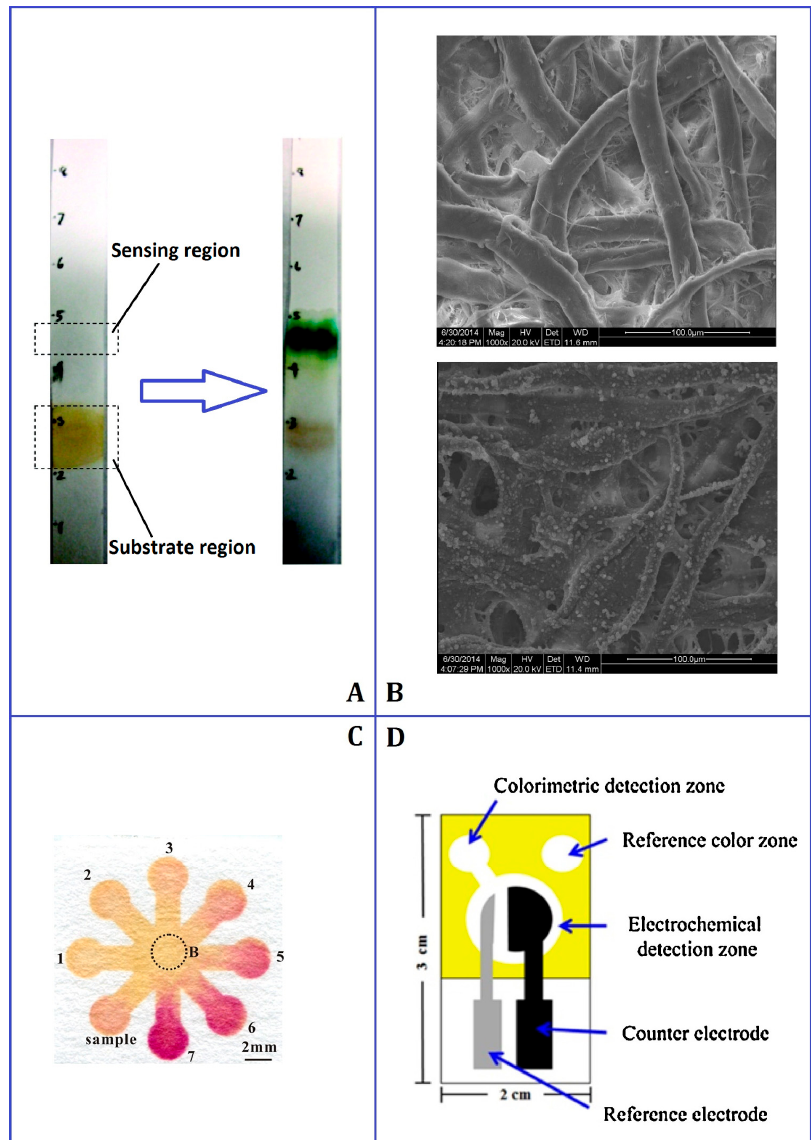
Figure 1. Representative μ PAD applications. ( A ) Bidirectional lateral flow bioactive paper sensor.